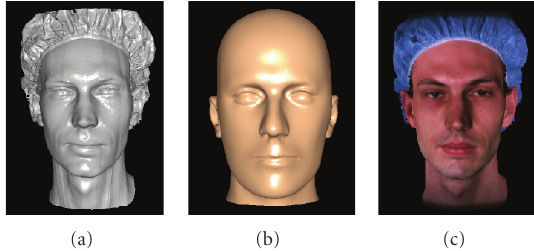
Figure 2: Face data: (a) scanned face geometry; (b) texture-mapped face scan; (c) generic